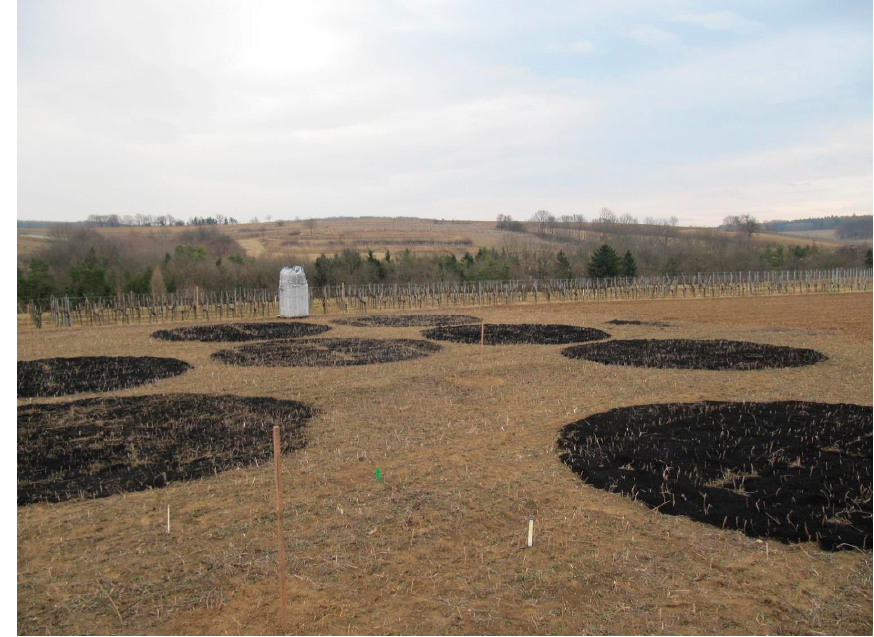
Figure 1. Application of biochar in Traismauer, Austria.